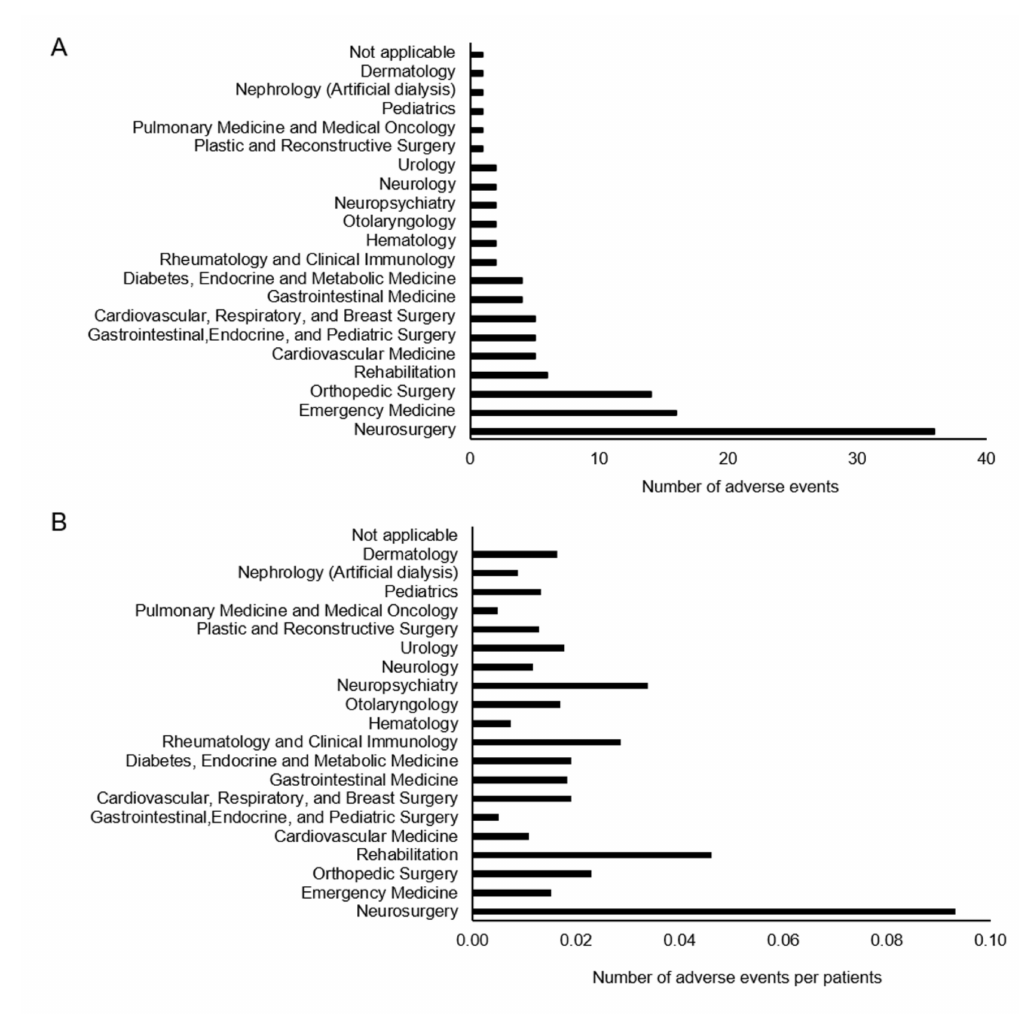
Figure 5. Number of adverse events by clinical department. ( A ) Number of adverse events by clinical department. ( B ) Number of adverse events by clinical department converted per patient. ( B ) results were obtained by dividing the number of adverse events by the number of people referred to the department of